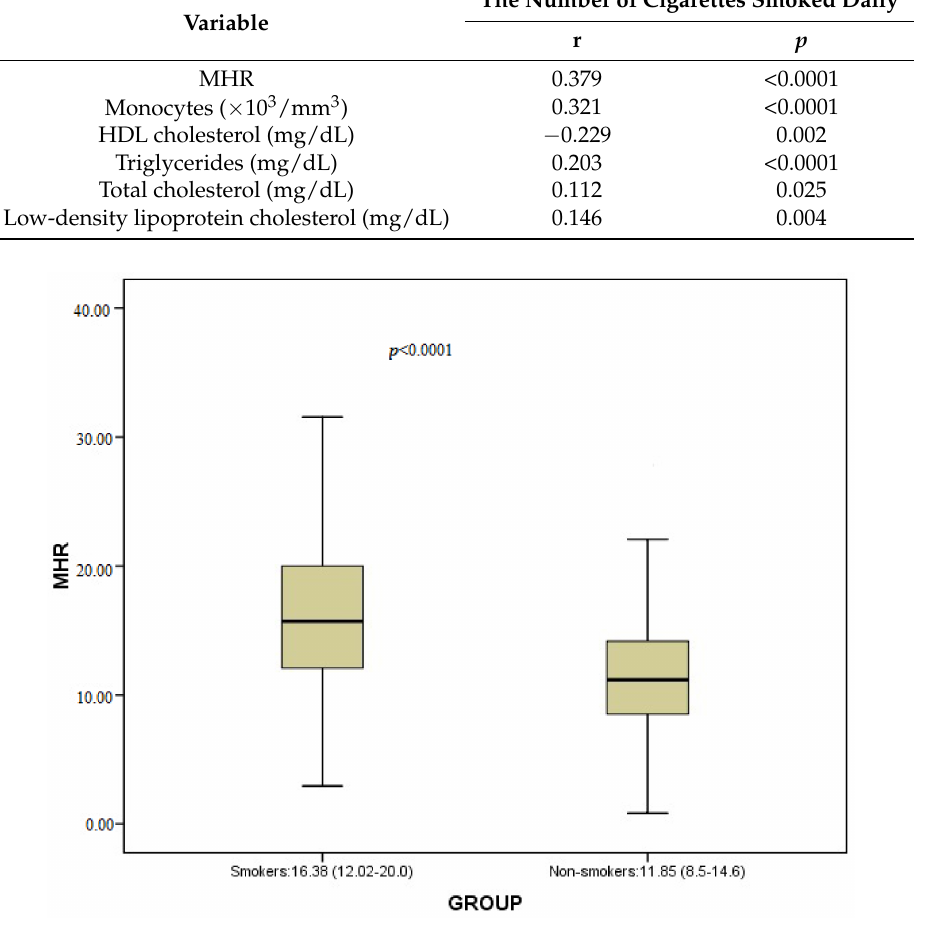
Figure 1. Comparison of MHR between smokers and non-smokers.